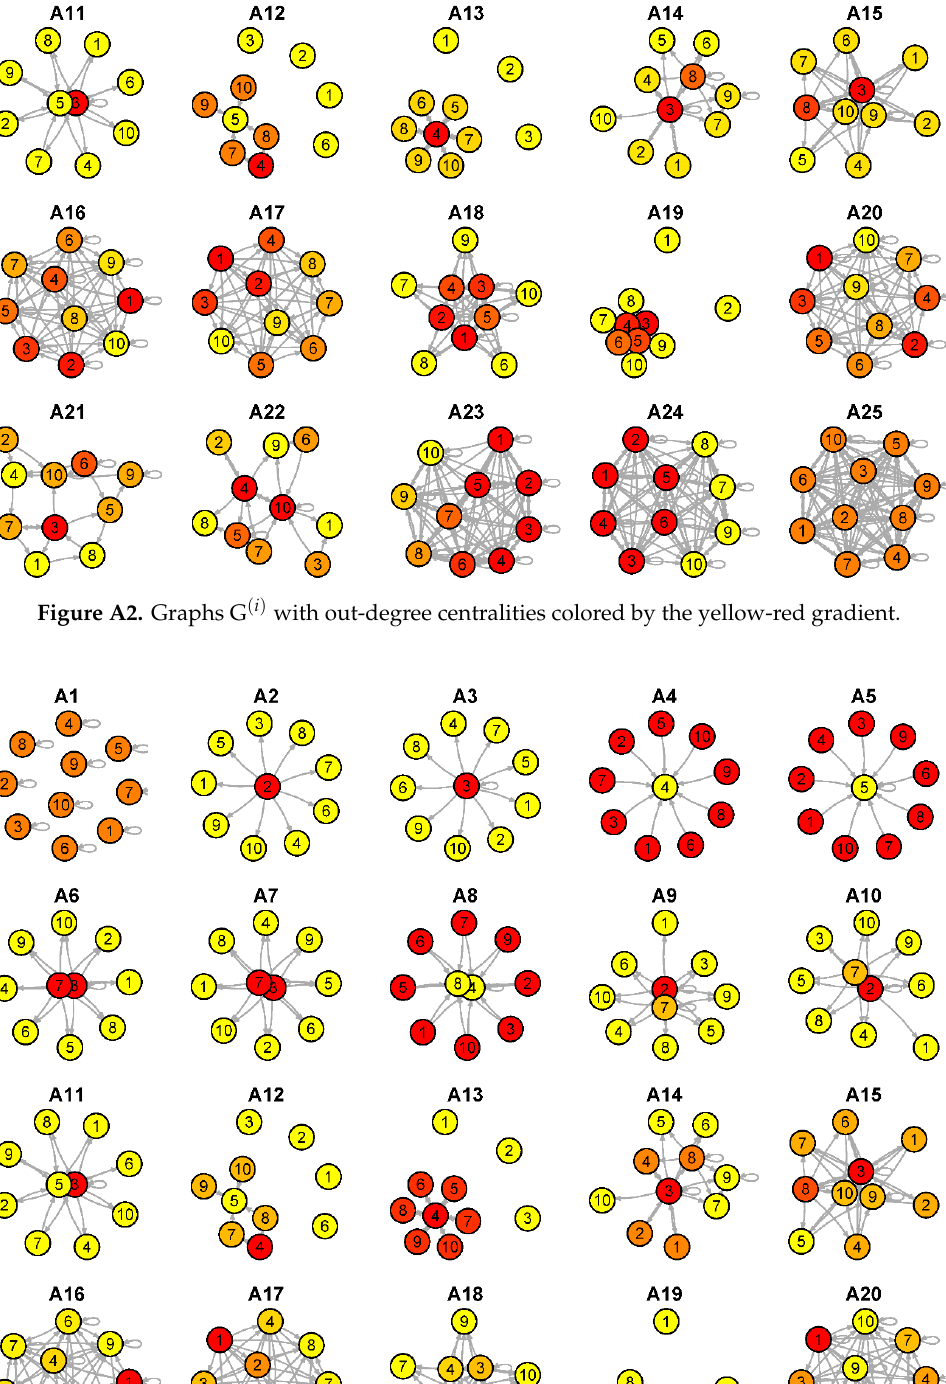
Figure 3. Graphs G ((cid:3036)) with closeness centralities colored by the yellow-red gradient.